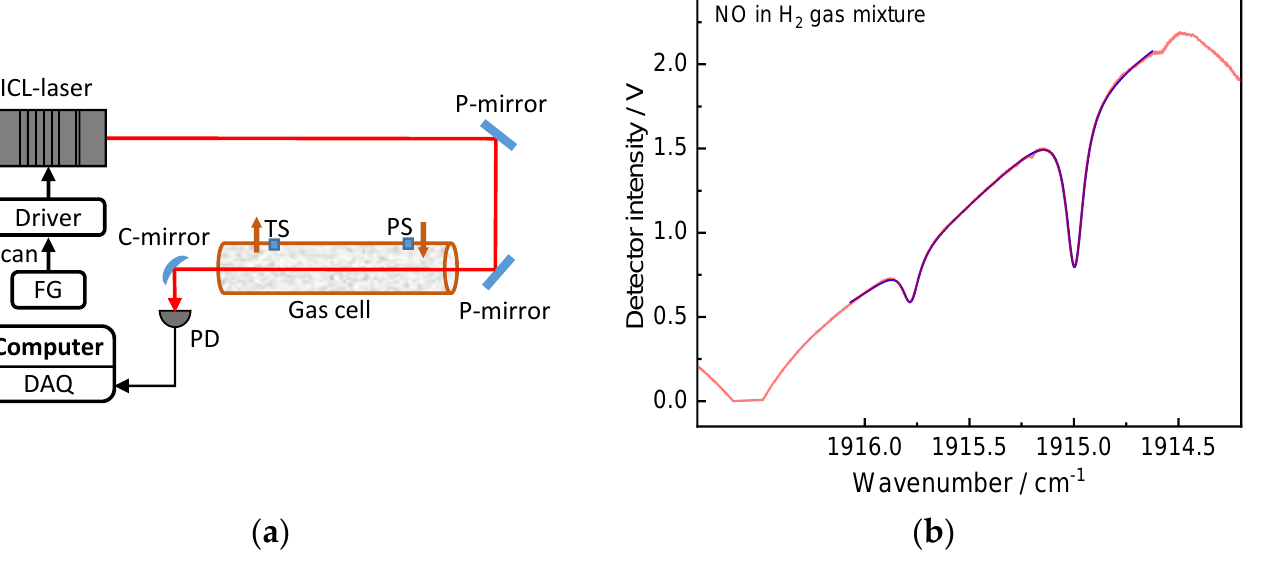
Figure 1. ( a ) The spectrometer’s experimental configuration for determining the pressure broadening coefficients, where PS: pressure sensor; PD: photodetector; FG: function generator; DAQ: data acquisition card; ( b ) Measured typical laser intensity with two NO absorption peaks.